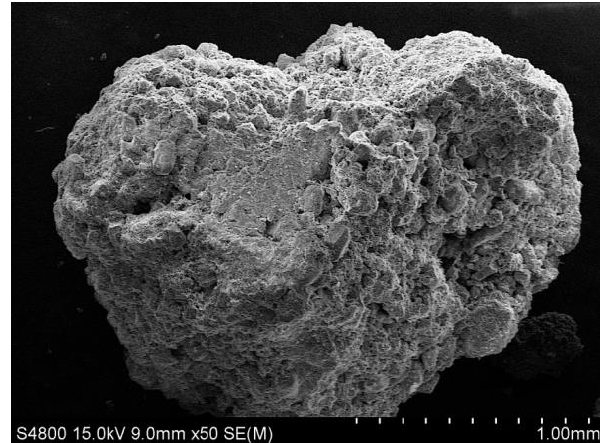
Figure 5. Scanning electron microscopy (SEM) photograph of a soil macroaggregate. Picture taken from a forest soil sample from Benitatxell, Alicante, Spain,